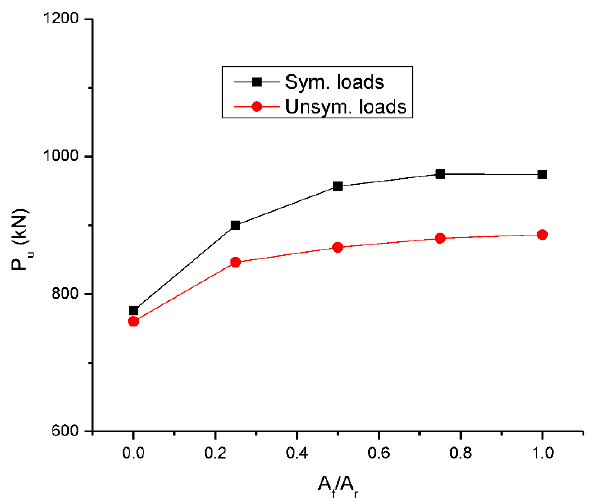
Figure 8. Change in ultimate load ( P u ) with the hybrid level.